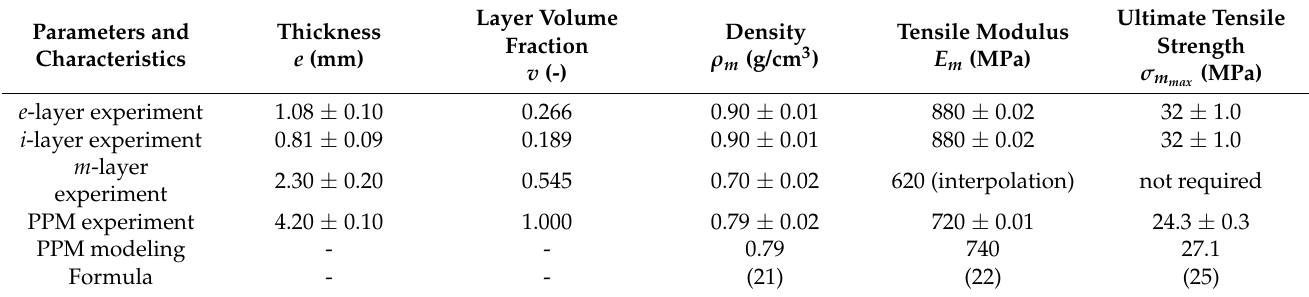
Table 6. Experimental and estimated properties of a PPM pipe and its